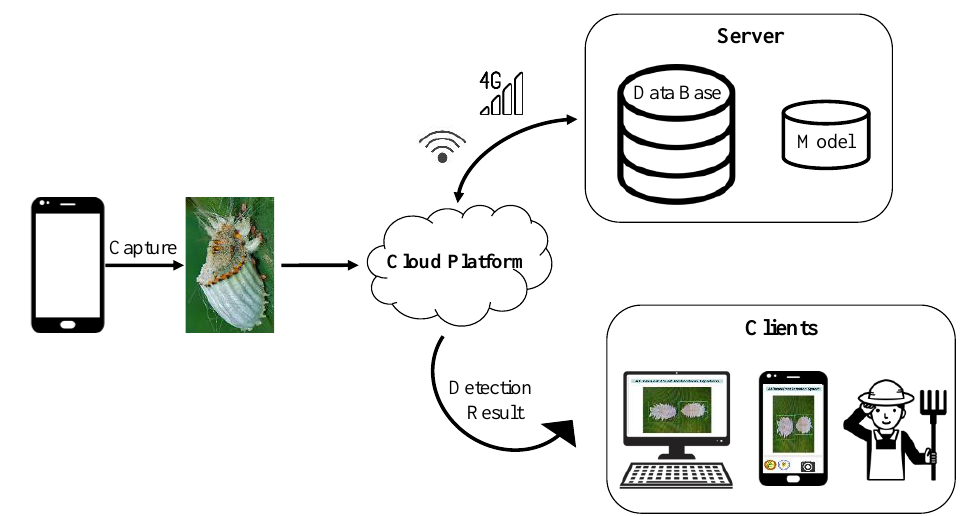
Figure 3. A flowchart of inferencing the model to the smartphone device.